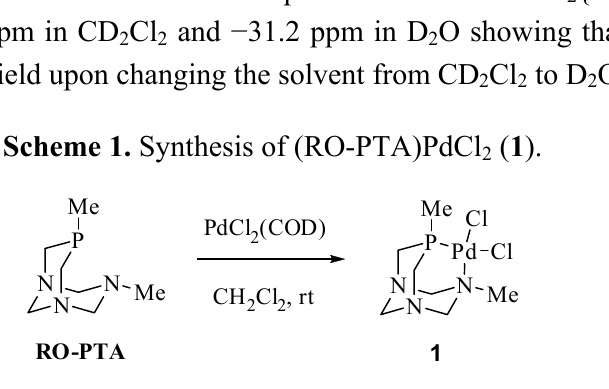
Figure 2. Thermal ellipsoid plot (50% probability) of 1 . Hydrogen atoms have been omitted for clarity. Selected bond lengths (Å) and angles (deg.): Pd1-N1 = 2.131(3), Pd1-P1 = 2.1884(12), Pd1-Cl1 = 2.3007(11), Pd1-Cl2 = 2.4074(11), N1-Pd1-P1 =